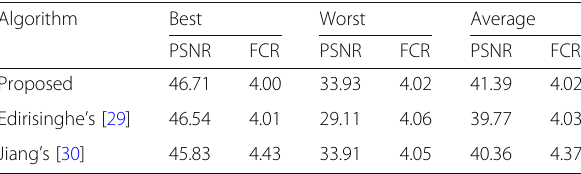
Table 5 Frame compression ratio and PSNR of bit rate control techniques for Kodak still images [36] (TCR: 4.0)